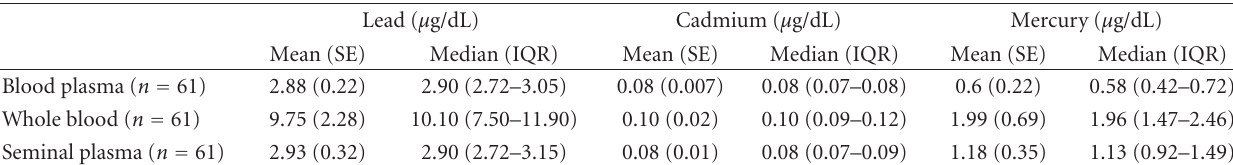
Table 3: Heavy metal concentrations in seminal, blood plasma, and whole